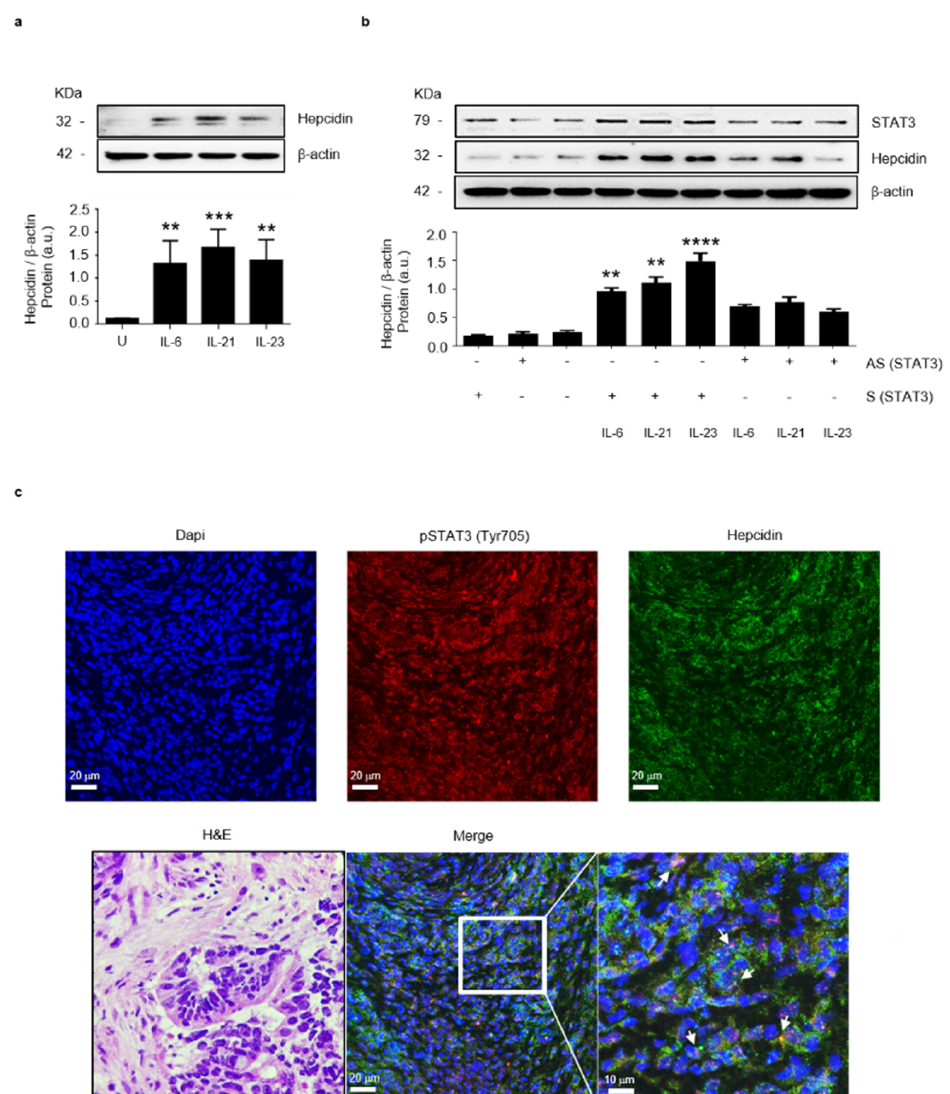
Figure 3. Stat3 regulates positively hepcidin expression in colon epithelial cells. ( a ) Representative Western blots showing hepcidin and β -actin in HCEC-1ct cells stimulated with IL-6, IL-21 and IL-23. Lower panel shows the quantitative analysis of hepcidin/ β -actin protein ratio, as measured by densitometry scanning of Western blots of 3 different experiments. Values are expressed in arbitrary units (a.u.) and indicate mean ± SD of all experiments; [Unstimulated (U) versus IL-6, ** p < 0.01; U versus IL-21, *** p < 0.001; U versus IL-23, ** p < 0.01]. ( b ) Representative Western blots showing p-Stat3, hepcidin and β -actin in HCEC-1ct cells transfected with sense (S) or Stat3 antisense (AS) oligonucleotide and then stimulated with IL-6, IL-21 and IL-23, as indicated in materials and methods. Lower panel shows the quantitative analysis of hepcidin/ β -actin protein ratio as measured by densitometry scanning of Western blots of 3 different experiments. Values are expressed in arbitrary units (a.u.) and indicate mean ± SD of all experiments; (S/IL-6 versus AS/IL-6, ** p < 0.01; S/IL-21 versus AS/IL-21, ** p < 0.01; S/IL-23A versus AS/IL-23A, **** p < 0.0001; n = 3). ( c ) Representative confocal laser scanning microscopy images showing p-Stat3 (Tyr 705) (red) and hepcidin (green) in CRC sections; nuclei are stained with 4 (cid:48) ,6-diamidino-2- phenylindole (DAPI) (blue). White arrows indicate cells co-expressing both p-Stat3 and hepcidin. The left image shows the hematoxylin/eosin (H&E) staining of a serial section taken from the same CRC tissue assessed by confocal